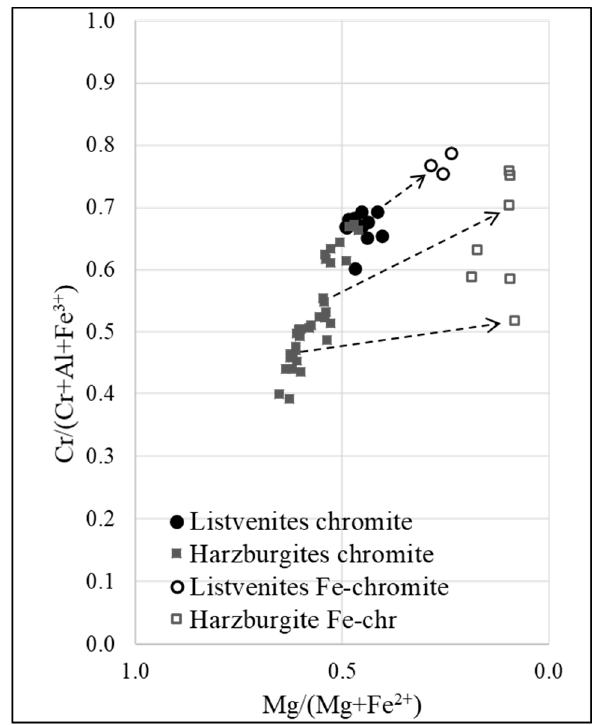
Figure 10. Mg/(Mg+Fe 2+ ) vs. Cr/(Cr+Al+Fe 3+ ) of chromites and ferrian chromites from listvenites and Figure 10. Mg / (Mg + Fe 2 + ) vs. Cr / (Cr + Al + Fe 3 + ) of chromites and ferrian chromites from listvenites and peridotites; the arrows indicate ferrian chromitization evolution. peridotites; the arrows indicate ferrian chromitization